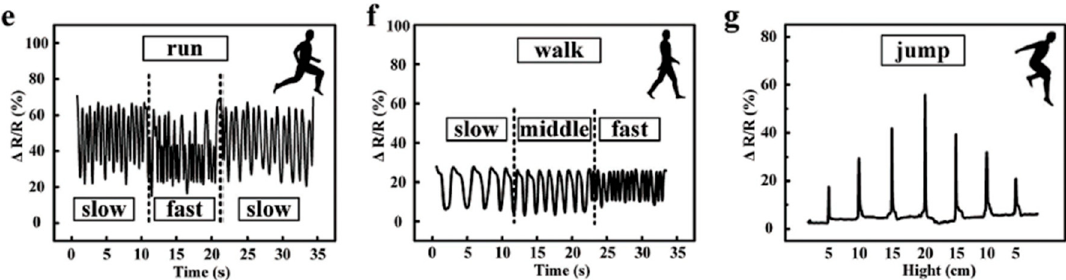
Figure 12. ( a ) Schematic of strain sensors based on PC-hydrogel and sensor placement in running shoes with detection under various actions: ( b ) standing ( c ) walking ( d ) jumping. ( e – g ) Varied resistance response of the PC-hydrogel strain sensor to di ff erent speeds for running and walking and jumping to di ff erent heights. Reproduced with permission from [149]. Copyright 2018 John Wiley and Sons.